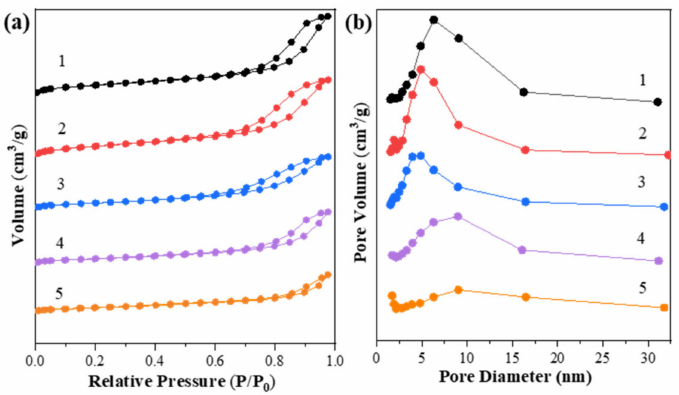
Figure 1. ( a ) N 2 physical adsorption–desorption isotherms and ( b ) BJH-pore size distributions of Zn-Mg-Al mixed oxides-supported gold catalysts: (1) Au 25 /MgAl-400; (2) Au 25 /Zn 0.05 MgAl-400; (3) Au 25 /Zn 0.33 MgAl-400; (4) Au 25 /Zn 3 MgAl-400; (5) Au 25